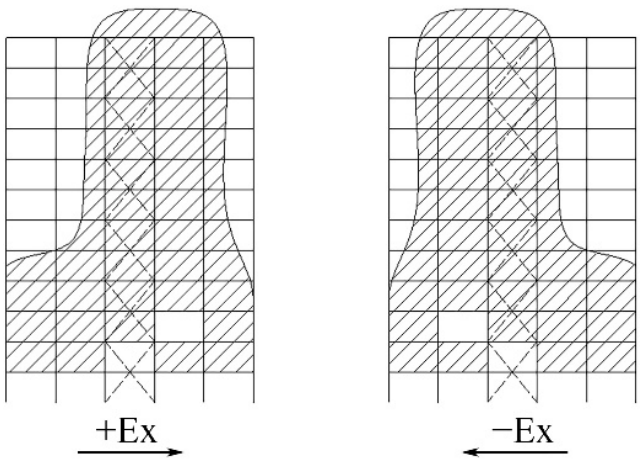
Figure 19. Load distribution hazard model for steel storage racks with bracings.